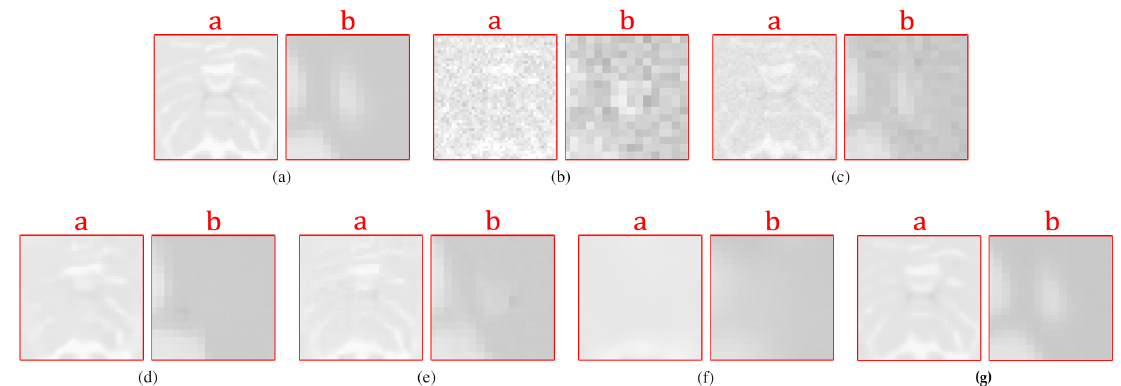
Figure 16. Zoom-in on the details labeled as “a” and “b” in Figure 15. Figures ( a – g ) correspond to the zoom-in of the Original image, the Noisy image, the KSVD, the PRINLM, the BM4D, the DnCNN and the NLSD in Figure 15, respectively.